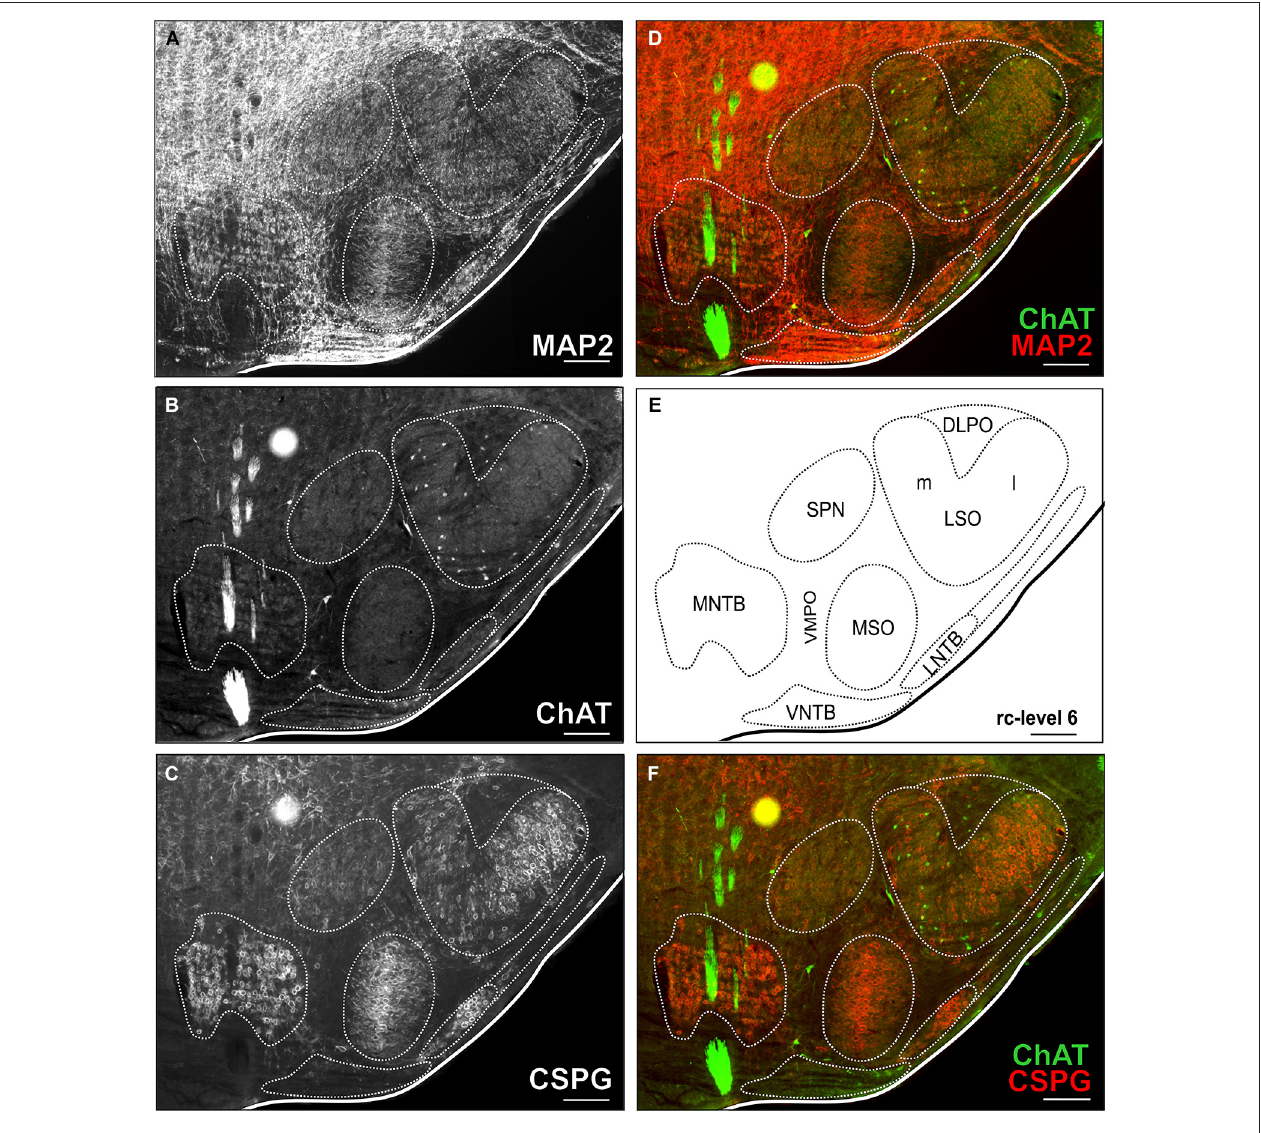
(Alexa Fluor 647, red) are shown in (D) and ChAT and CSPG (Cy 3, 570; red) in (F) . ChAT positive cells were easily detected in the ChAT stain alone as well as in overlay with both overview stains (MAP and CSPG). Scale bar in (A–F) : 500 µ